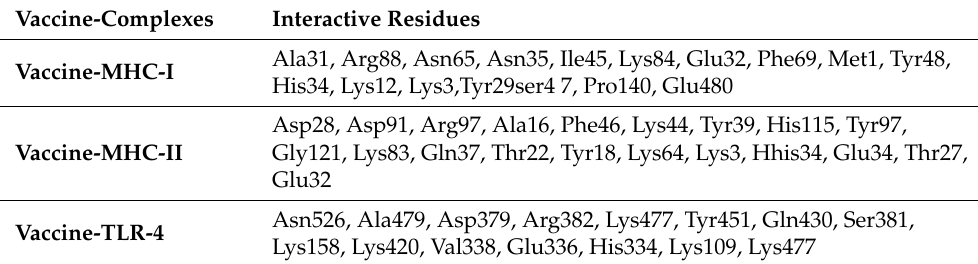
Table 5. List of interactive residues MHC-I, MHC-II, and TLR-4